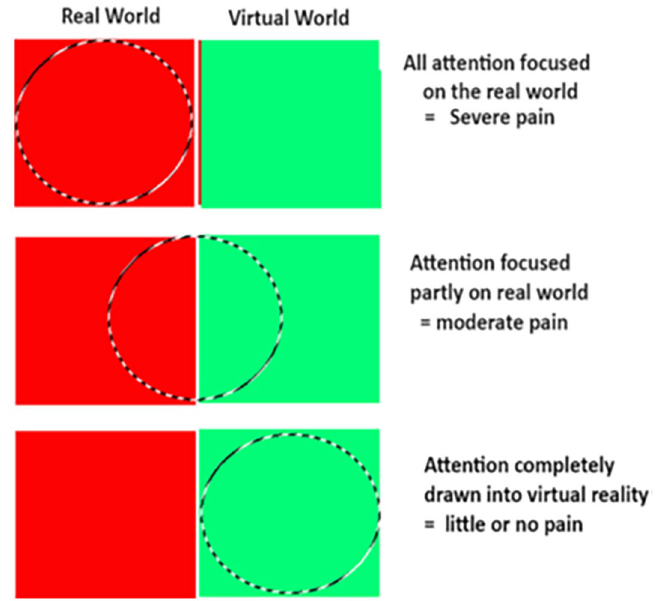
Figure 1. Increasing the illusion of “being there” in VR may increase the amount of attention drawn into VR, leaving less attention available to process incoming nociceptive signals. If so, participants may feel less pain during Avatar VR. Copyright Hunter Hoffman, www. vrpain.